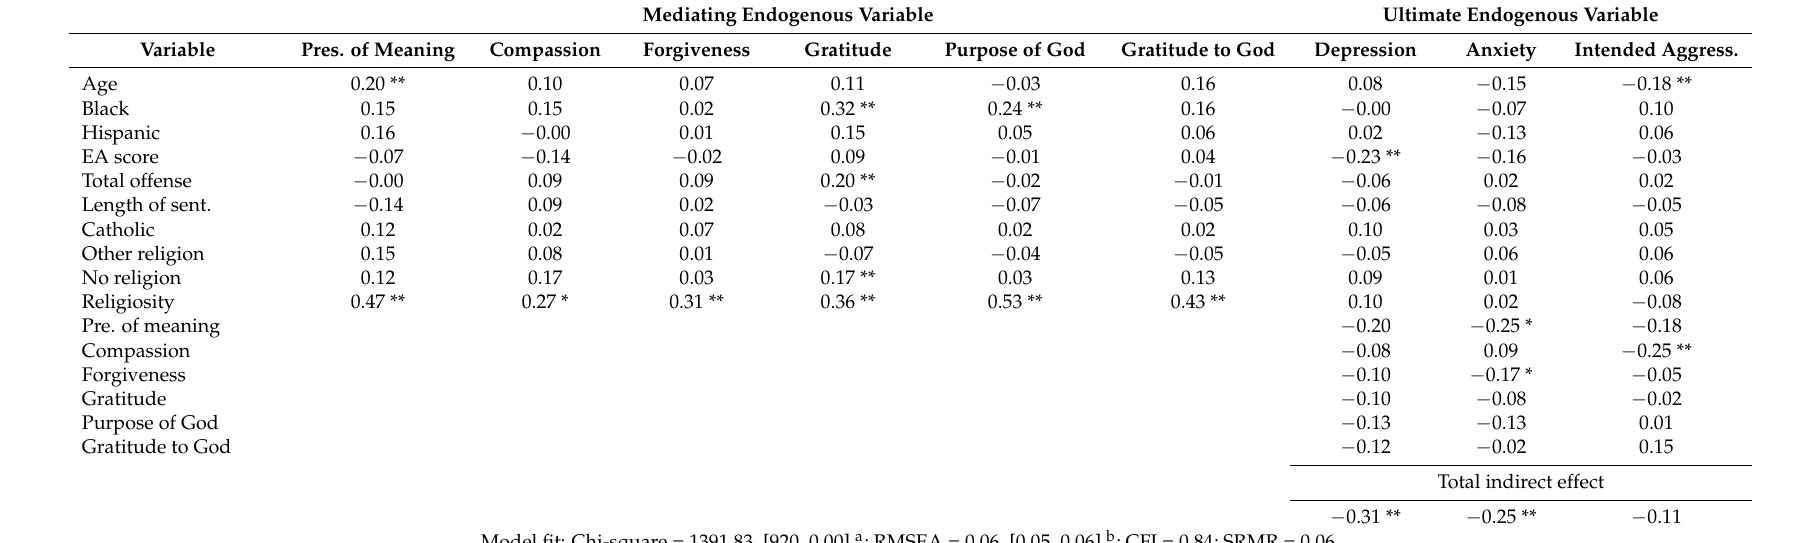
Table 3. Final Model of State Depression, State Anxiety, and Intended Aggression with All Six Mediators Included ( n = 163); with Standardized Coefficients. Mediating Endogenous